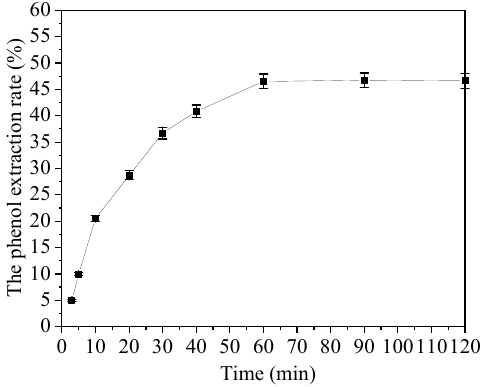
Figure 10. Effect of reaction time on phenol extraction rate.